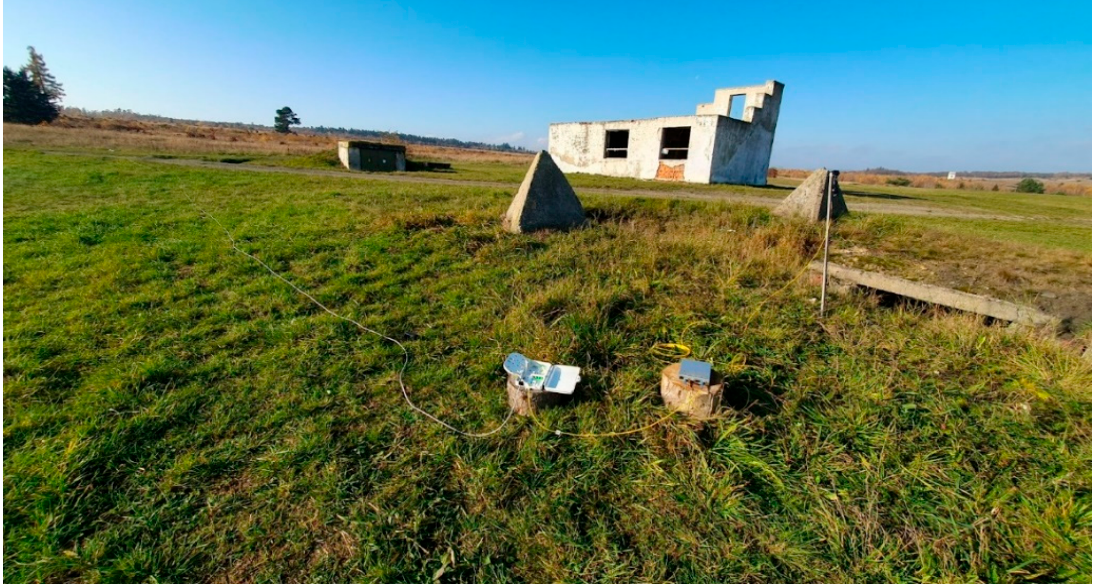
Figure 13. Installation of the polarization sensor and supply cabling in the B ř ezina military area.